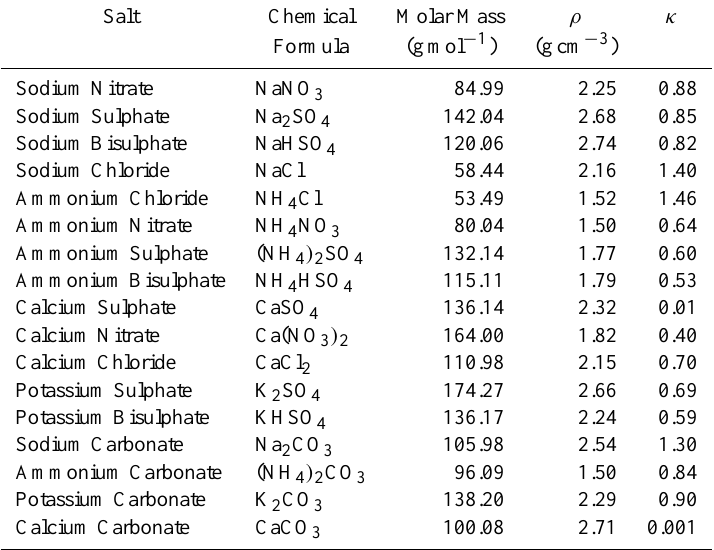
Table 3. Properties of inorganic salts potentially extracted from regional soil samples. Properties obtained from Padr´o et al. (2010).